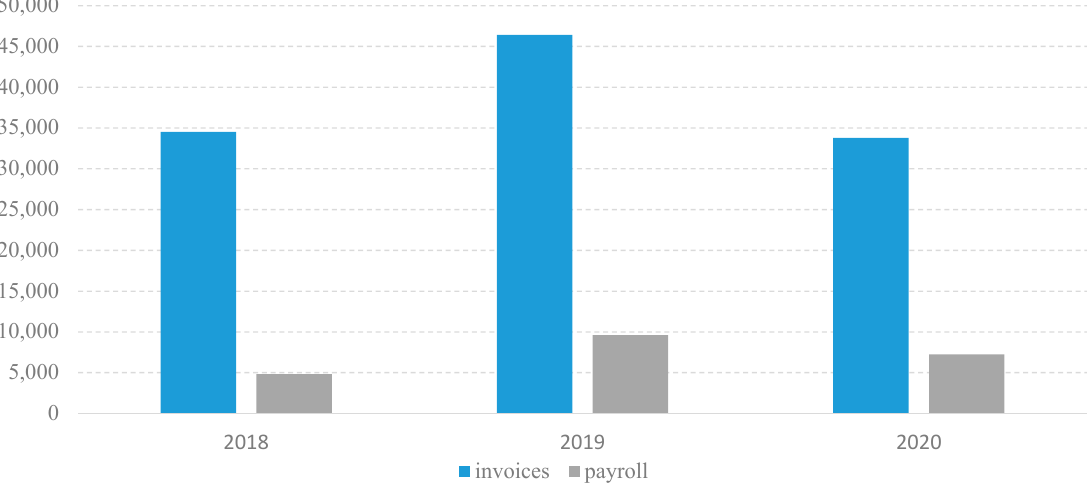
Figure 6. Number of financial, accounting and payroll documents generated in one of Polish SSCs. Source: own study based on data gathered in one of Polish SSCs.